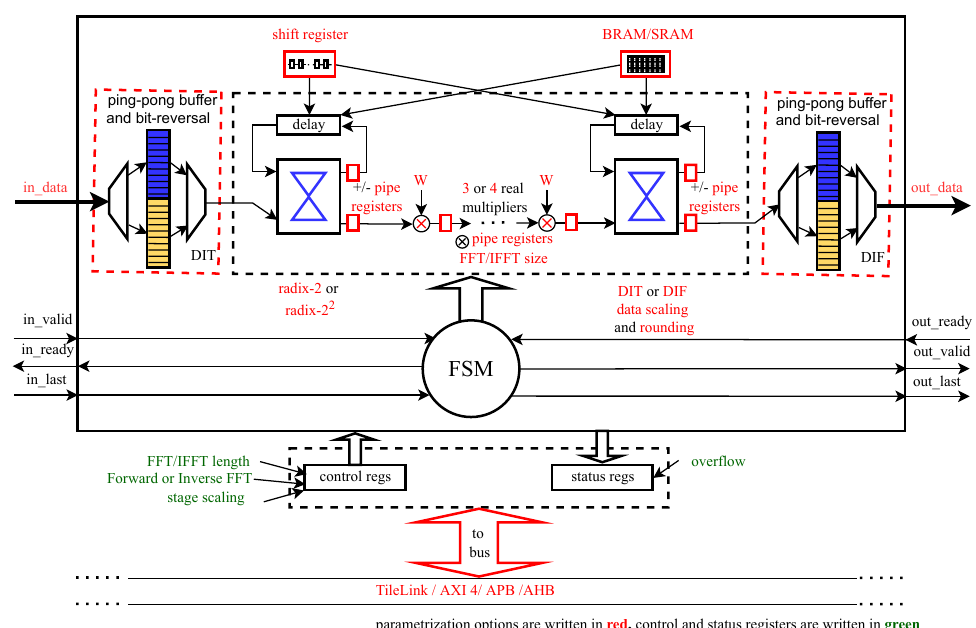
Figure 8. Interface of the used SDF-FFT processor generator showing input and output signals as well as module control and status registers.